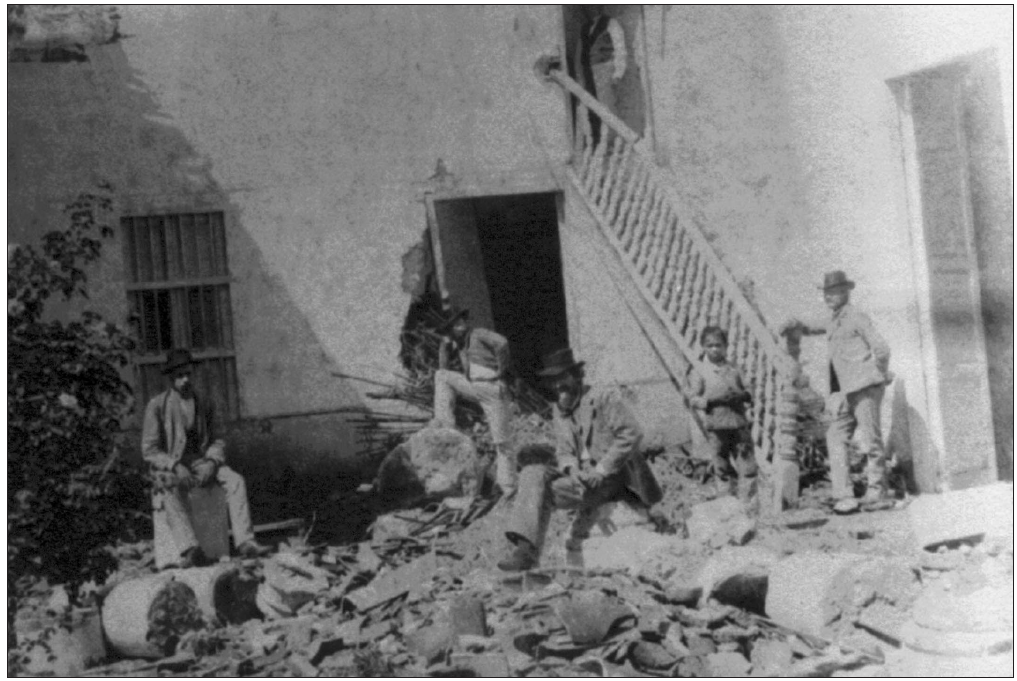
Fig. 3. Damage caused by the earthquake of 1894 in Mérida, Venezuela (from Romero,